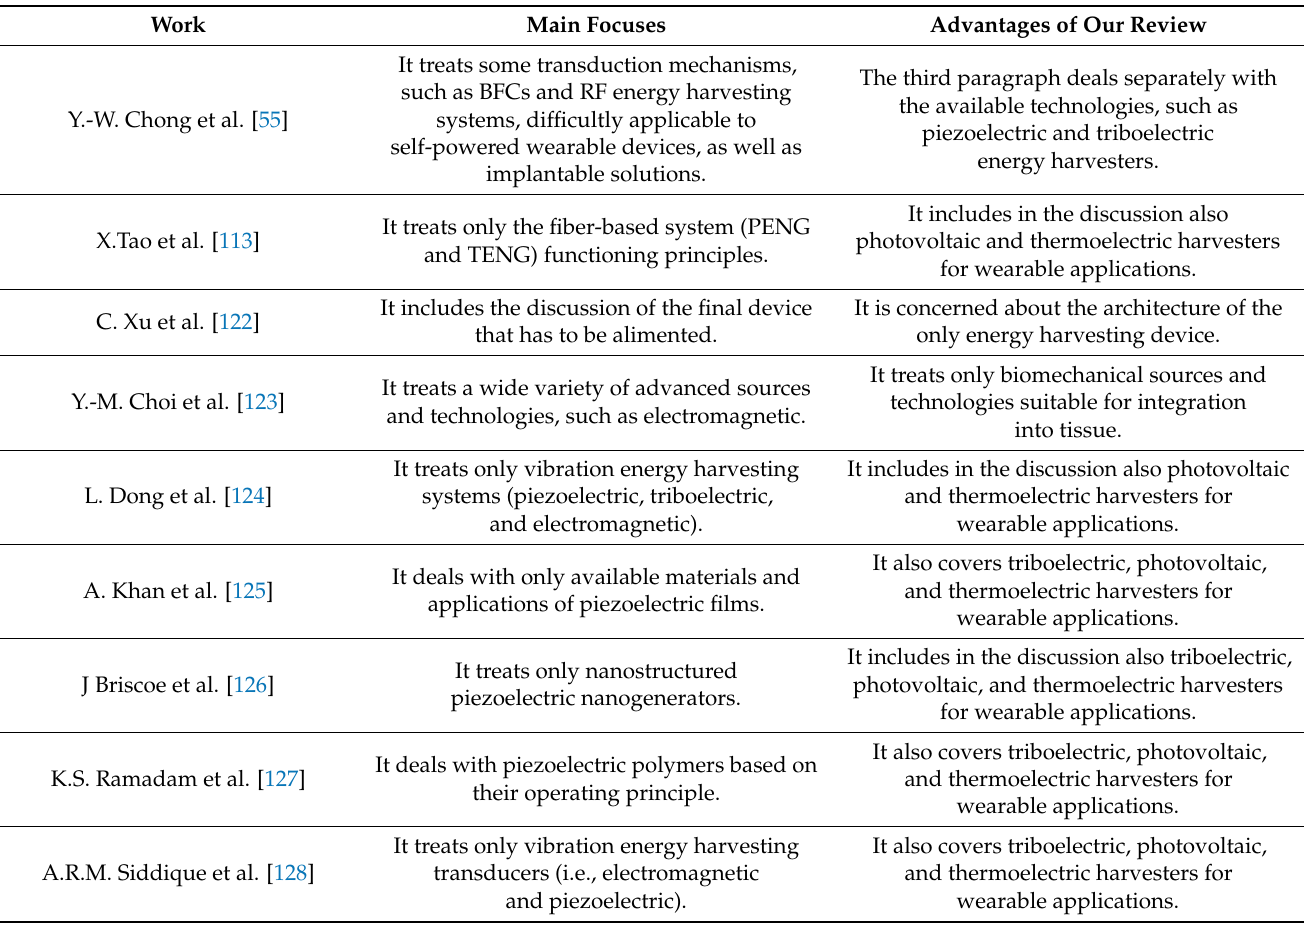
Table 7. Comparative table with review papers reported in the